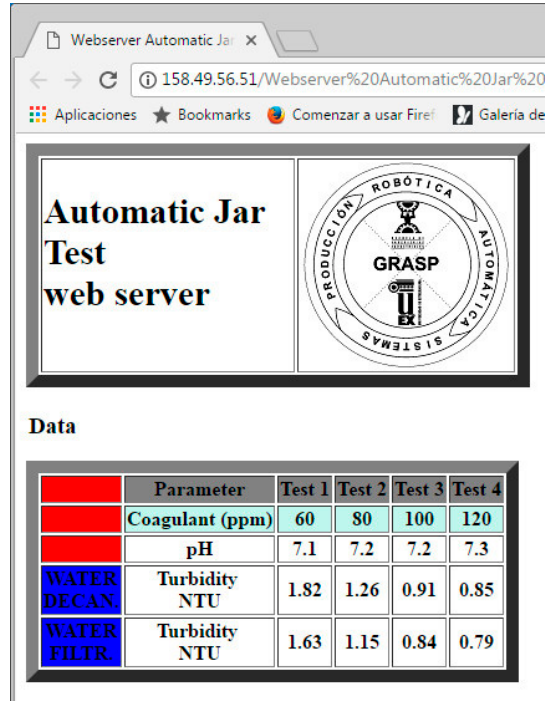
Figure 15. Web page for remote monitoring of the JT results.